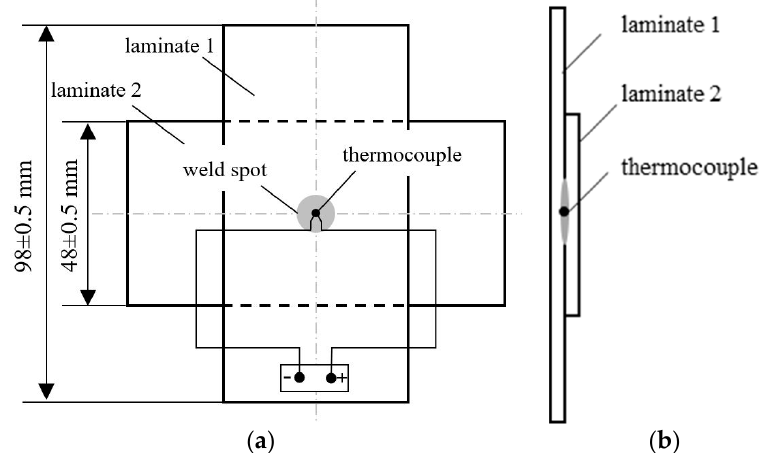
Figure 5. A schematic drawing of the test specimen illustrating the laminate placement, dimensions, and the thermocouple location in relation to the designated weld spot. ( a ) Top view of the specimen, and ( b ) side view of the specimen.